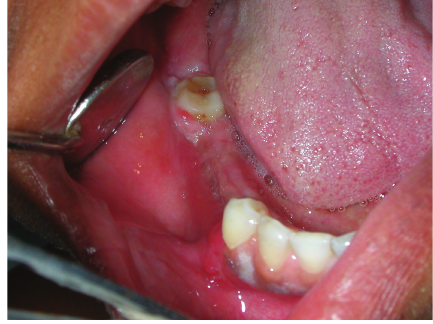
Figure 5: Clinical photograph of postoperative healed lesion.